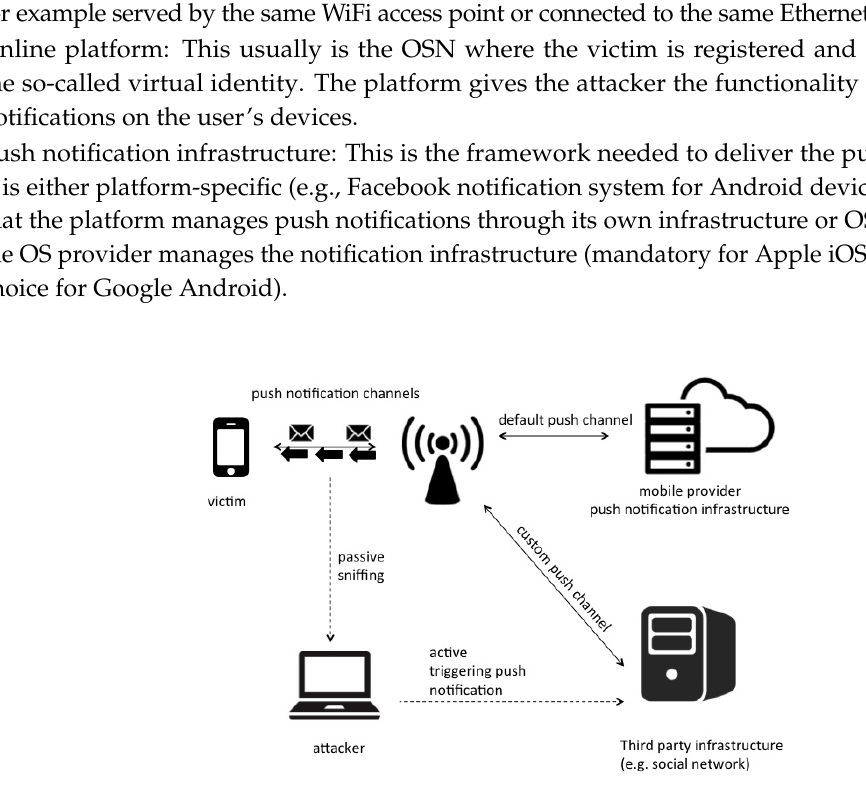
Figure 2. Attack